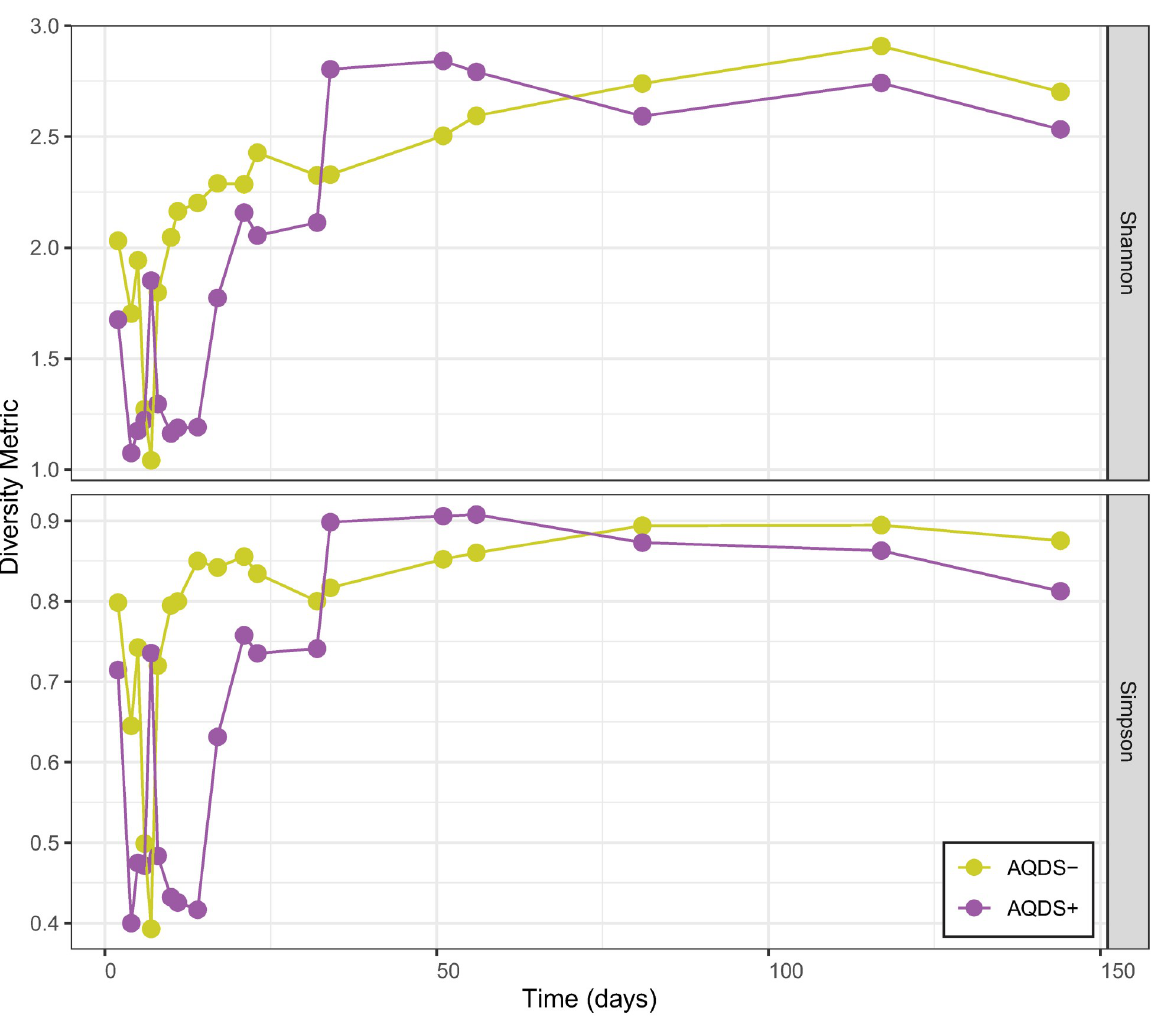
Fig 3. Changes in alpha diversity over time. Change over time in average alpha diversity as measured by the Shannon (top) and Simpson (bottom) indices during early and late phases of microbial community development in batch systems with (AQDS+) or without (AQDS–) added electron